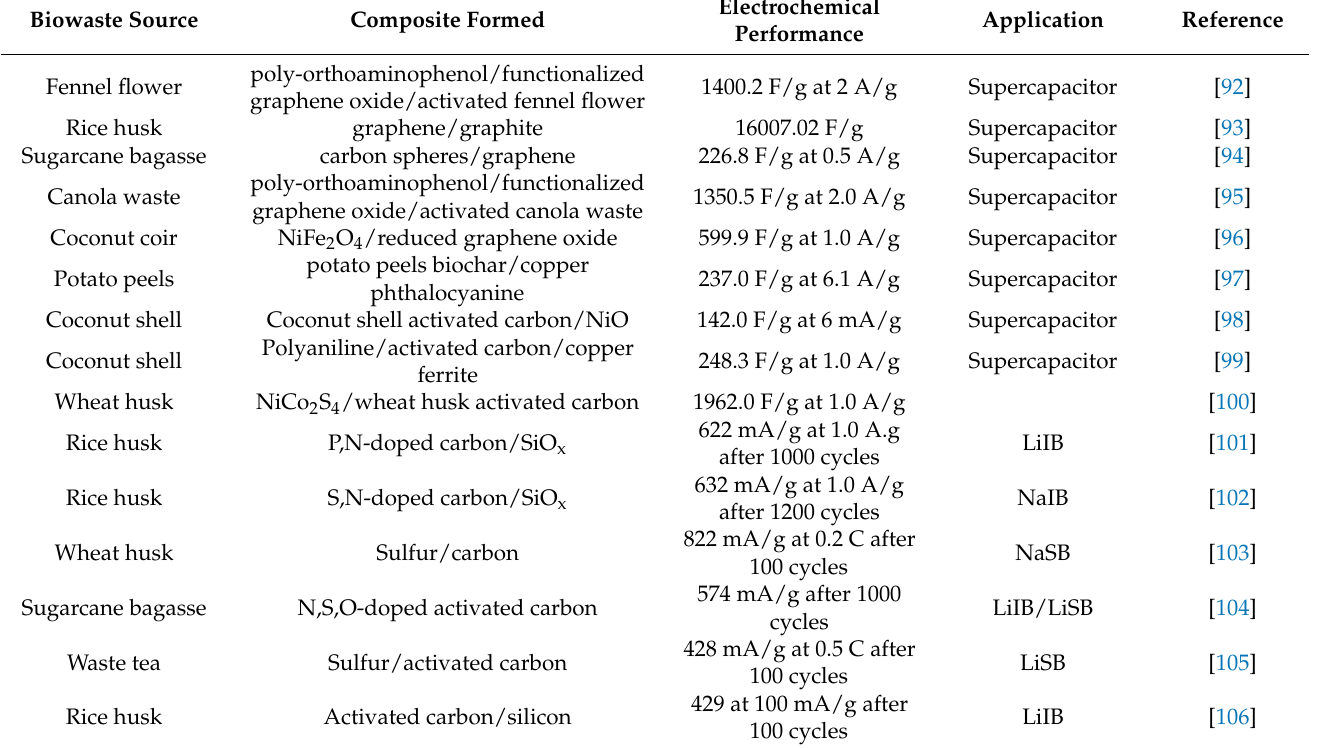
Table 5. Performance of biowaste-based